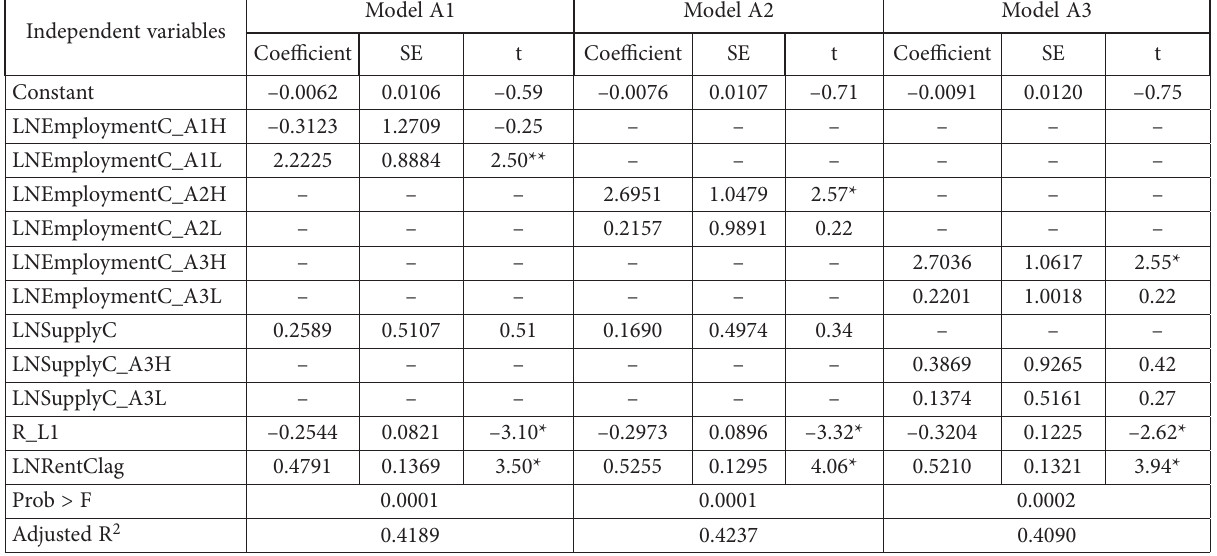
Table 6. The short-term equations with asymmetric variables (source: own study)